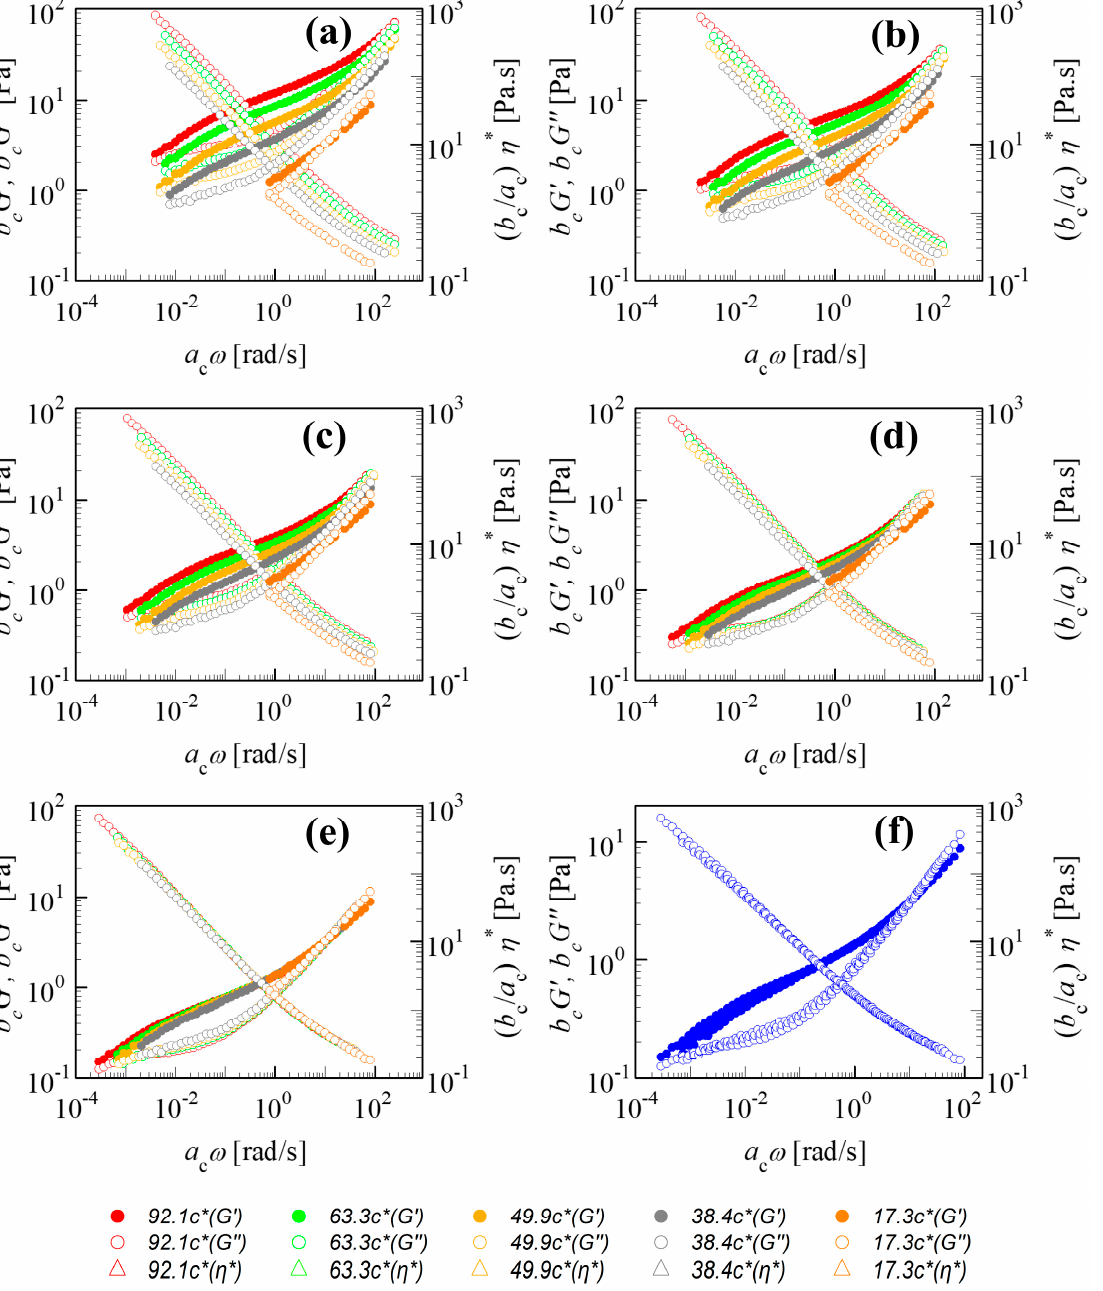
Figure 1. Time–concentration superposition (TCS) of SAOS data belonging to a 18M PAAm–sucrose–water solution at semidilute concentrations from 17.3 c * to 92.1 c *. TCS merges the linear viscoelastic data G ′ , G ″ , η *( ω , c/c *) thereby generating master curves at the reference concentration of 17.3 c * as measured by SAOS. ( a ) Original data before shifting; ( b ) 25% shifting towards the reference state; ( c ) 50% shifting the curves; ( d ) 75% shifting the curves; ( e ) 100% shifting the curves; ( f ) a master curve of G ′ ( ω , c/c *), G ″ ( ω , c/c *), η *( ω , c/c *) after completion of the TCS procedure. The shifting and plotting were executed using IRIS Rheo-hub software [8].